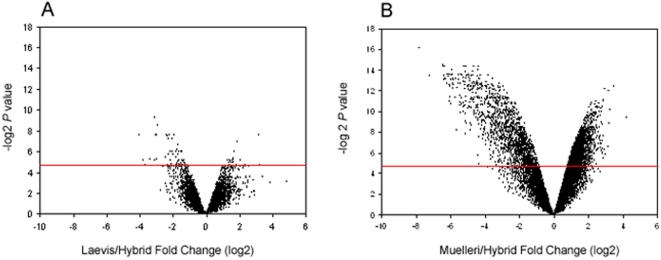
Volcano plots from FDR corrected t-tests of statistical significance (vertical axis) against magnitude of expression change (horizontal axis), where each point corresponds to a gene/transcript.Expression change (fold-change) is defined as a log2-transformed ratio of mean nonhybrid to mean hybrid expression level. (A) Xenopus laevis vs. Hybrids; (B) Xenpous muelleri vs. Hybrids. The red line denotes FDR adjusted alpha 0.05. The horizontal deviation from 0 towards the right or left reflects hybrid underexpression or overexpression, respectively.